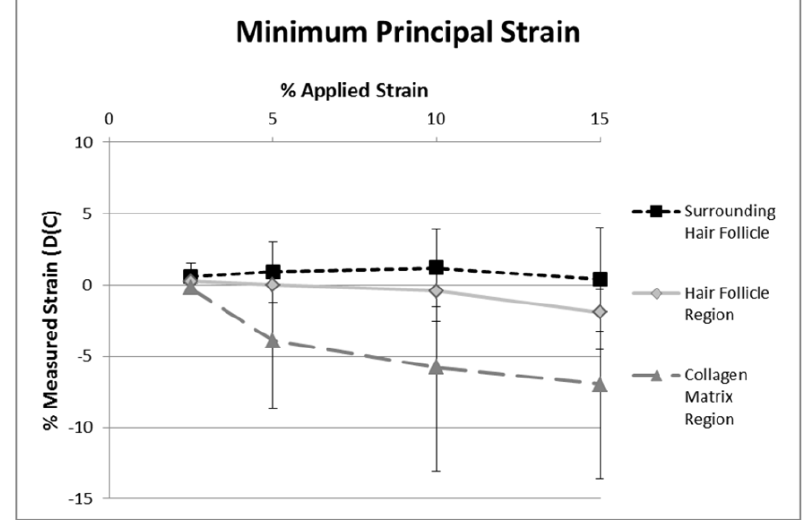
Figure 8. Averaged minimum principal strain, as measured by DIC, versus applied strain. There was a statistically significant difference ( p = 0.02) between the different locations. Minimum principal strains immediately surrounding the hair follicle were positive, indicating an expansion of collagen in this zone. In contrast, minimum principal strains in primarily collagenous zones were negative, indicating a Poisson’s effect. Error bars represent ±1 Standard